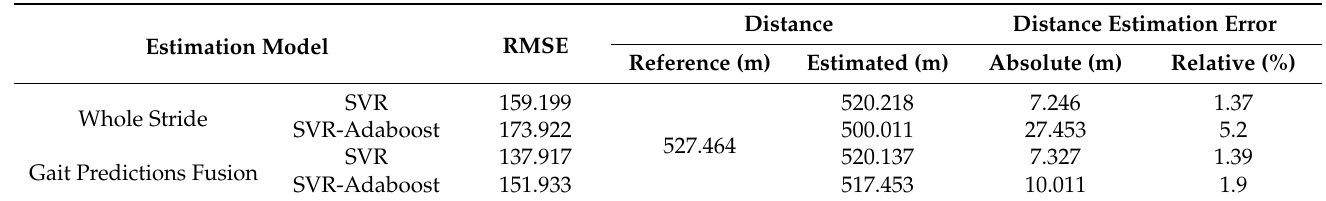
Table 6. Stride length estimation errors by using multi-gait features and full stride features.